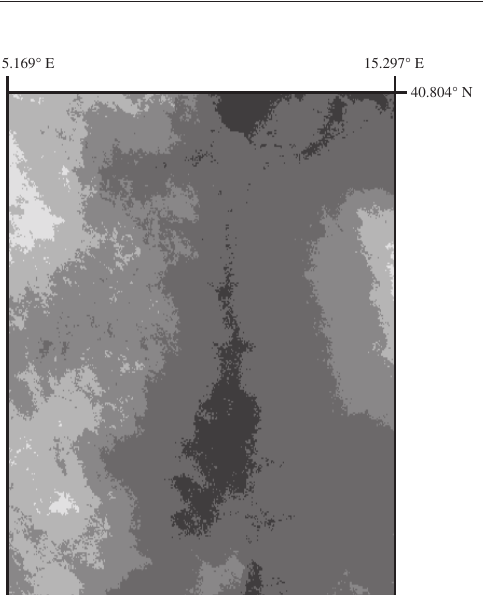
Fig. 2. Differences between InSAR-ICA DEMs re- lated to the period June-December 1995; the gray color ranges from maximum subsidence (black) to maximum uplifts (white). See text for more details.